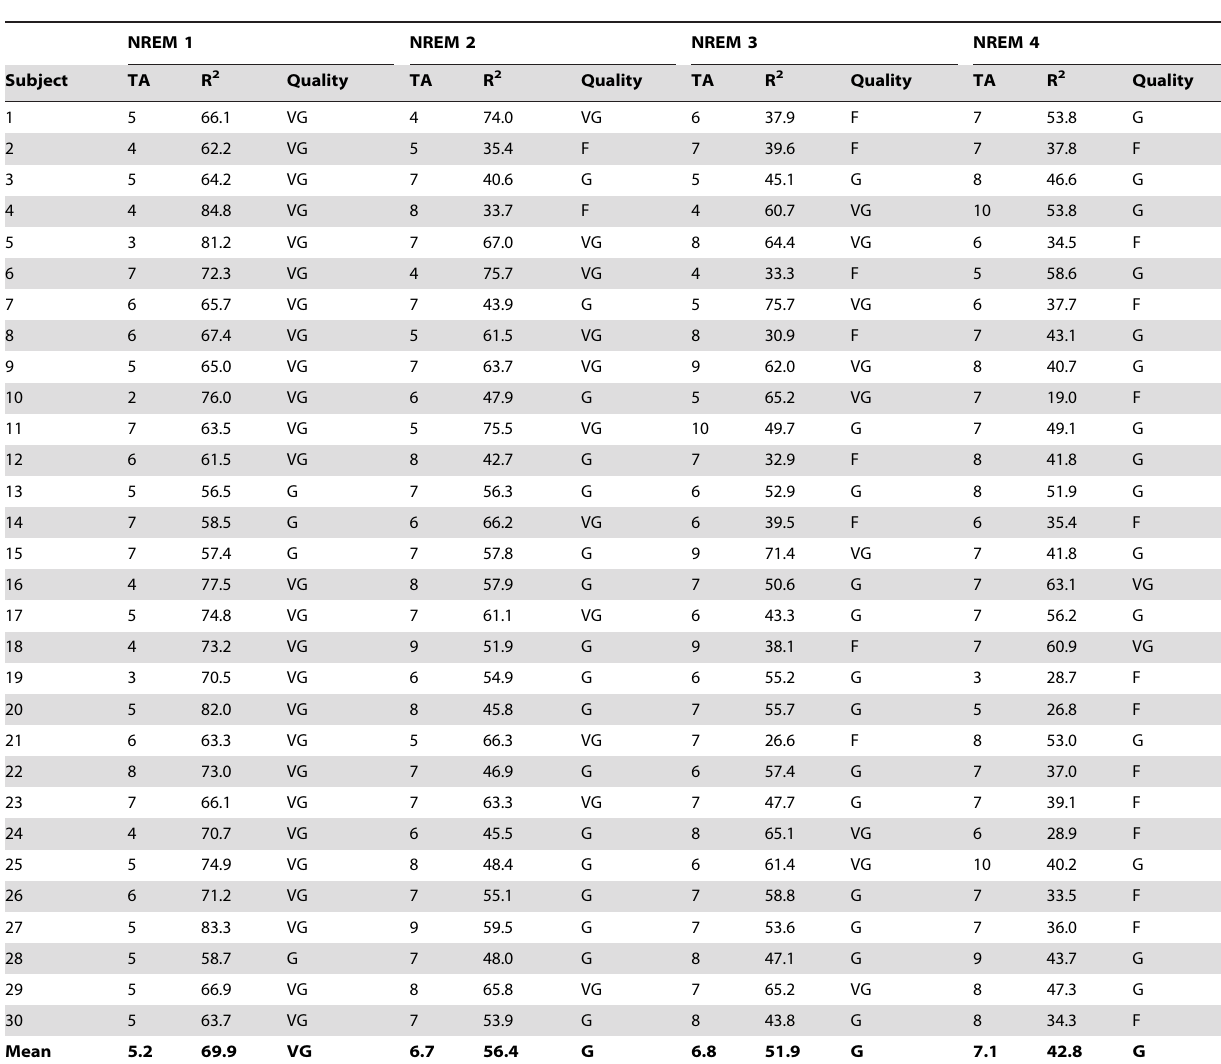
Table 1. Fit of the NTP model to individual subject data across the